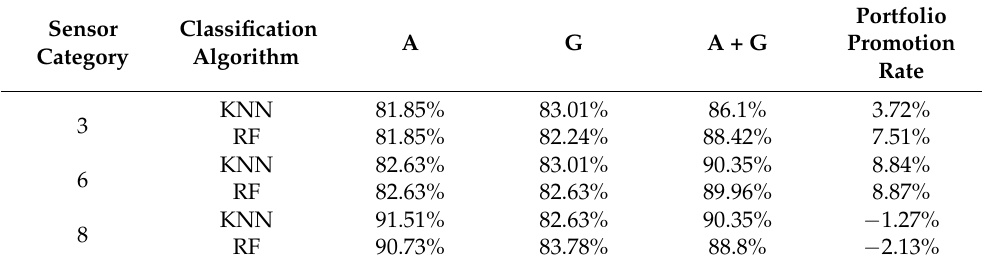
Table 4. Accuracy Evaluation of Single Position Hoisting Recognition Model.